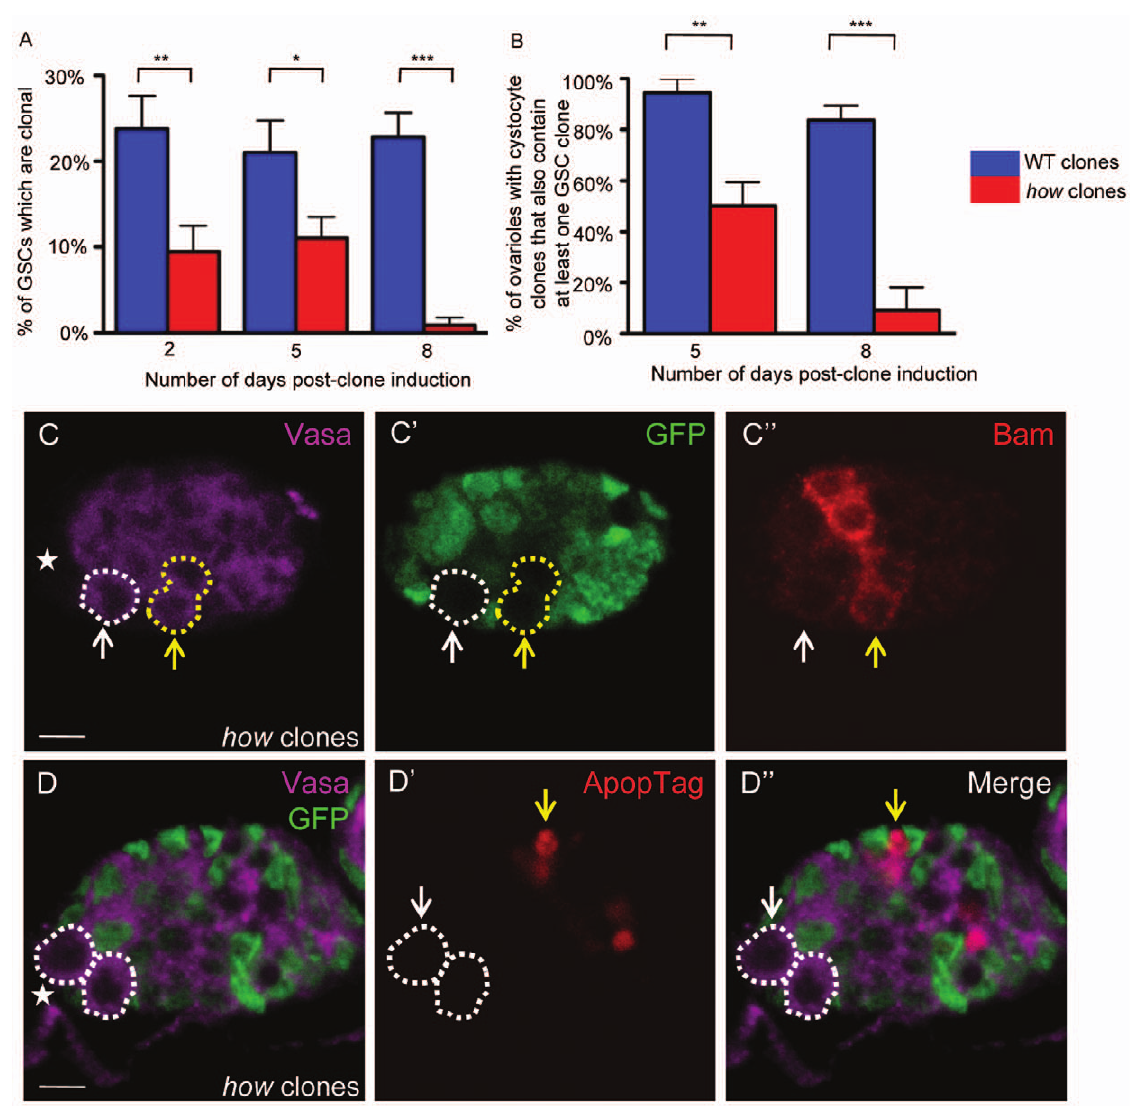
Figure 2. HOW is required intrinsically by ovarian GSCs for their maintenance. ( A ) Comparison of wild type and how stru GSC clone maintenance over time at 2 (p=0.005), 5 (p=0.02), and 8 days (p , 0.0001) post-clone induction, indicates that GSCs lacking HOW are lost from the niche over time. ( B ) how stru clonal cystocytes persist longer than how stru GSC clones. 94% (n=18) of wild type cystocyte clones five days and 84% (n=43) eight days post-clone induction also contain a parental GSC clone. In ovaries containing how stru cystocyte clones, only 50% (n=30) at 5 five days and 9% (n=11) at 8 days post-clone induction still possess a parental GSC clone, indicating how cystocytes derived from how clonal GSCs lose their progenitor GSC over time (p=0.001 at 5 days and p , 0.0001 at 8 days). ( C ) how stru GSC clones (white q ) do not express detectable levels of the differentiation marker Bam (red). how clonal cystocytes (yellow q ) derived from how GSCs express Bam at normal levels and timing. ( D ) A germaria containing ApopTag-negative how GSCs (white dotted line) with a dying IGS cell (yellow q ). Scale bar 5 m m. Anterior marked